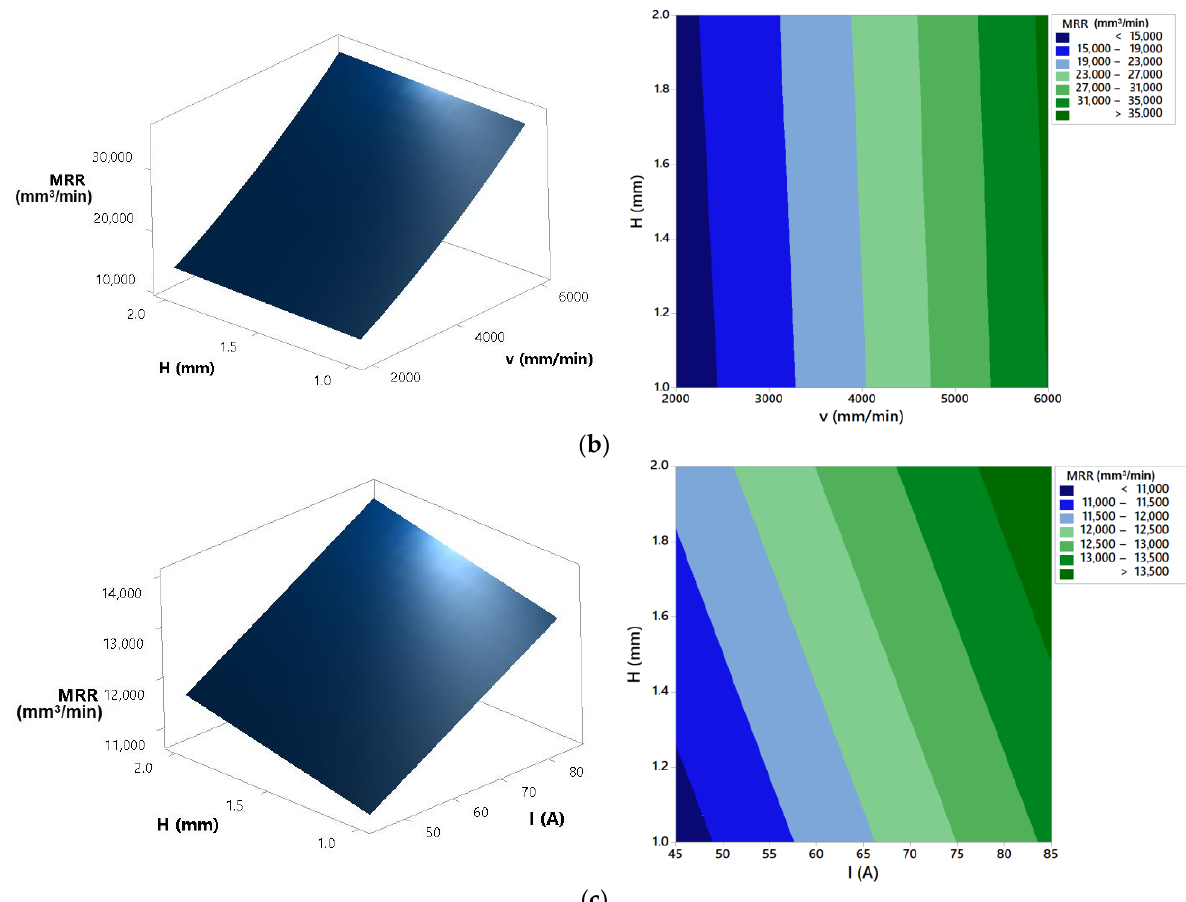
Figure 14. Effects of process parameters on material removal rate: ( a ) H = 1.5 mm, ( b ) I = 85 A, and ( c ) v = 2000 mm/min.